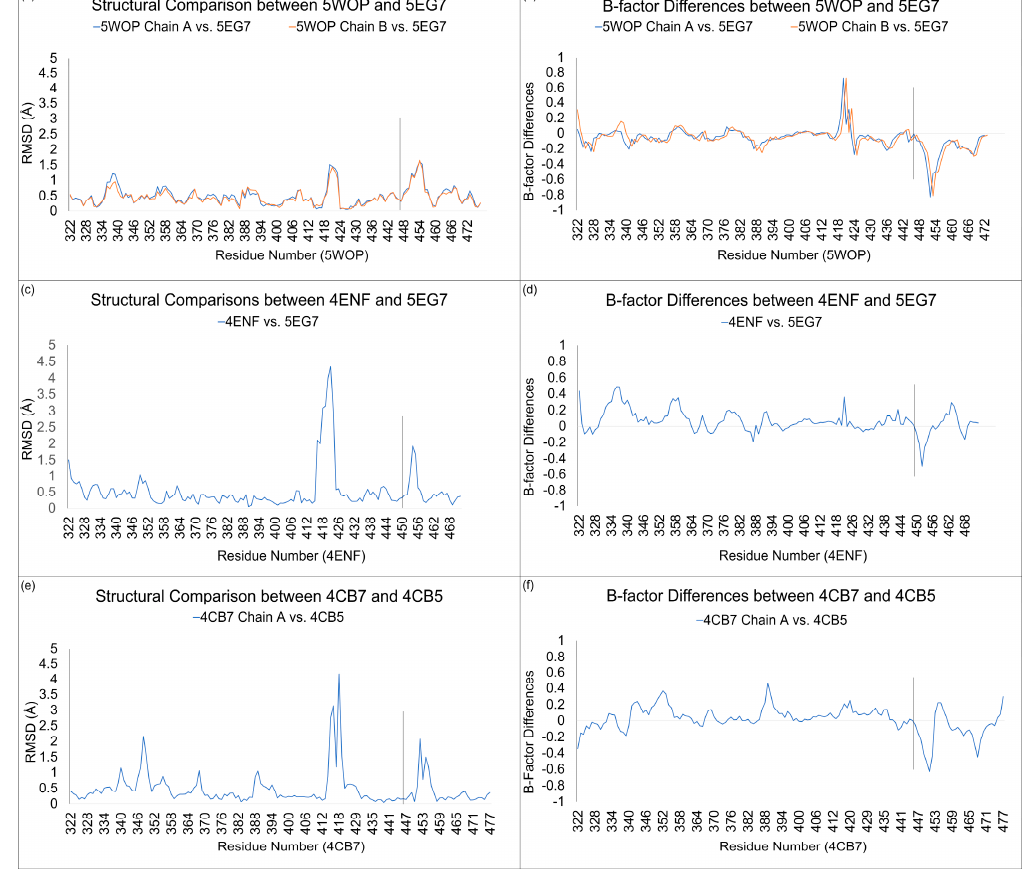
Figure 5. ( a ) RMSD and ( b ) B-factor comparisons between chain A and chain B of 5WOP [13]